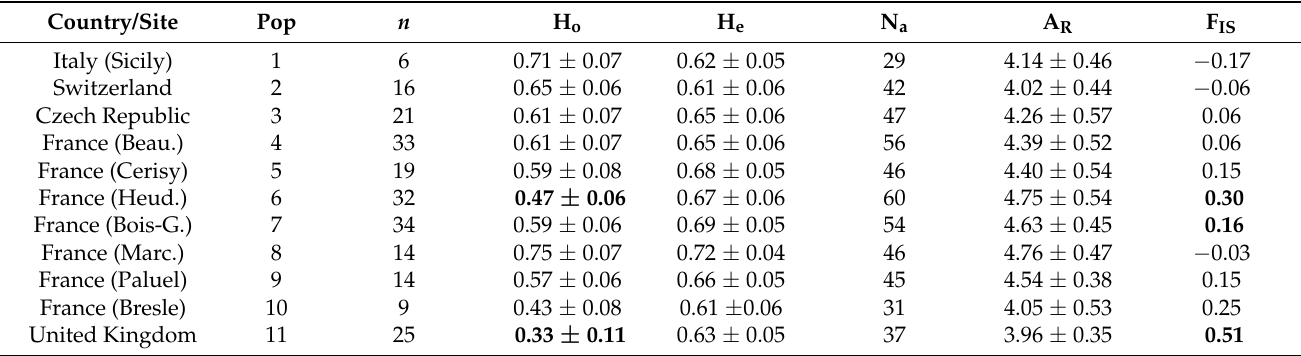
Table 2. Genetic diversity measures (mean ± SE) in the 11 sampled populations of Anax imper- ator from Europe. Legend: n = number of sampled individuals, H o = observed heterozygosity, H e = expected heterozygosity, N a = number of alleles, A R = allelic richness, F IS = inbreeding coef- ficient. Bolded H o indicate populations presenting a significant departure from HWE condition. Bolded F IS indicate a bootstrapped 95% confidence interval that does not overlap